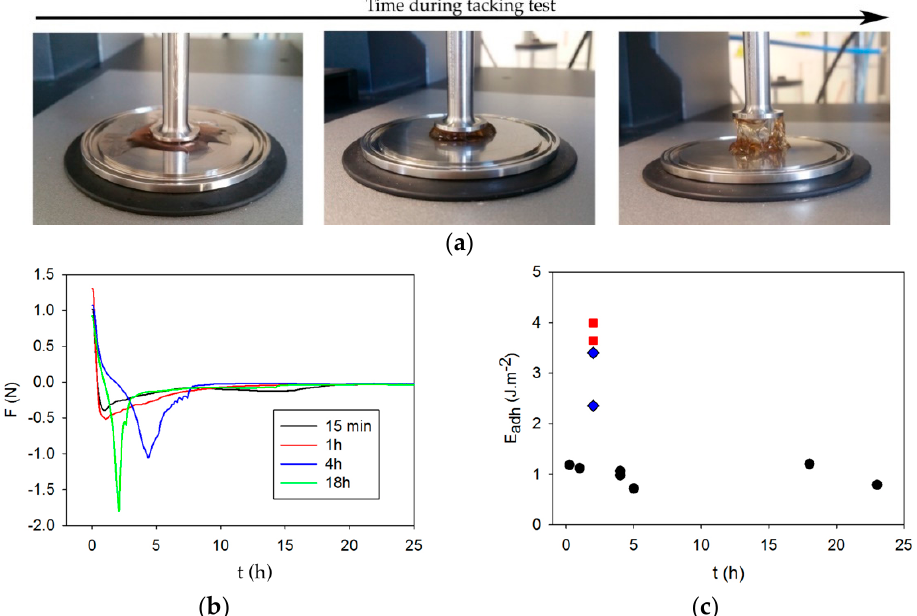
Figure 2. Adhesion of Alg–Cat gels onto stainless steel plates. ( a ) Behaviour of the Alg–Cat gel during retraction of the upper plate at a speed of 100 µm·s − 1 ; ( b ) force versus time curves for the Alg–Cat gels aged for different durations before the tacking tests, performed at a retraction speed of 100 µm·s − 1 ; ( c ) influence of the aging time and of the retraction speed (( ): 10 µm·s − 1 , ( ♦ ): 100 µm·s − 1 , ( ): 1 mm·s − 1 ) on the specific adhesion energy of the Alg–Cat gels on steel plates.